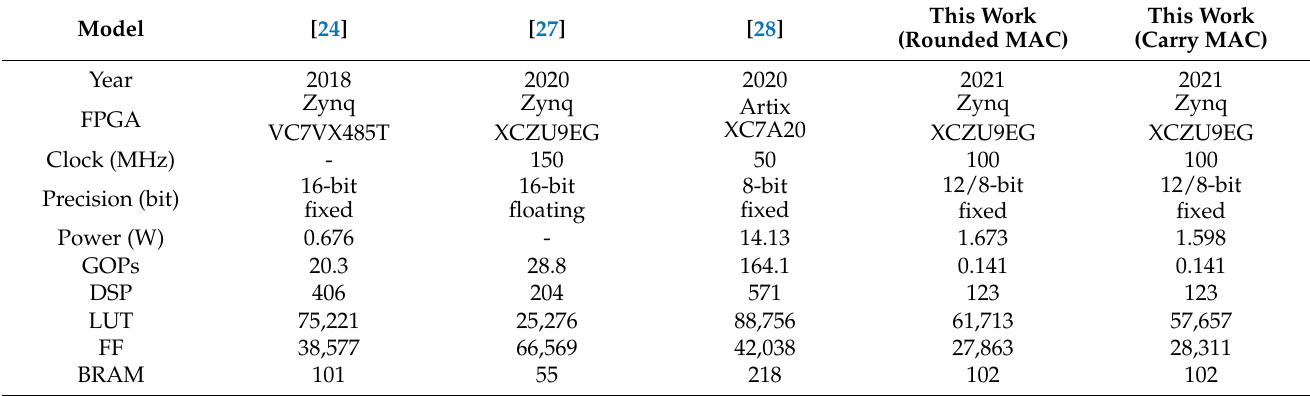
Table 6. Results comparison with previous